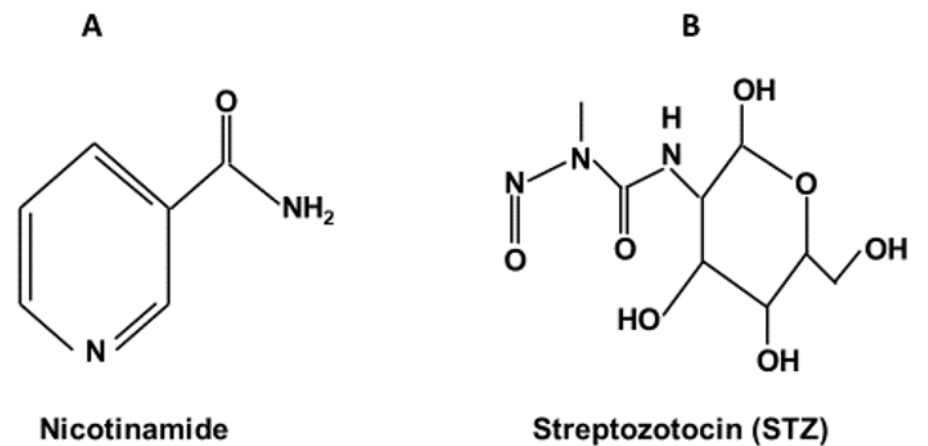
Figure 1. Chemical structures of nicotinamide and streptozotocin. ( A ): nicotinamide; ( B ): strepto- zotocin